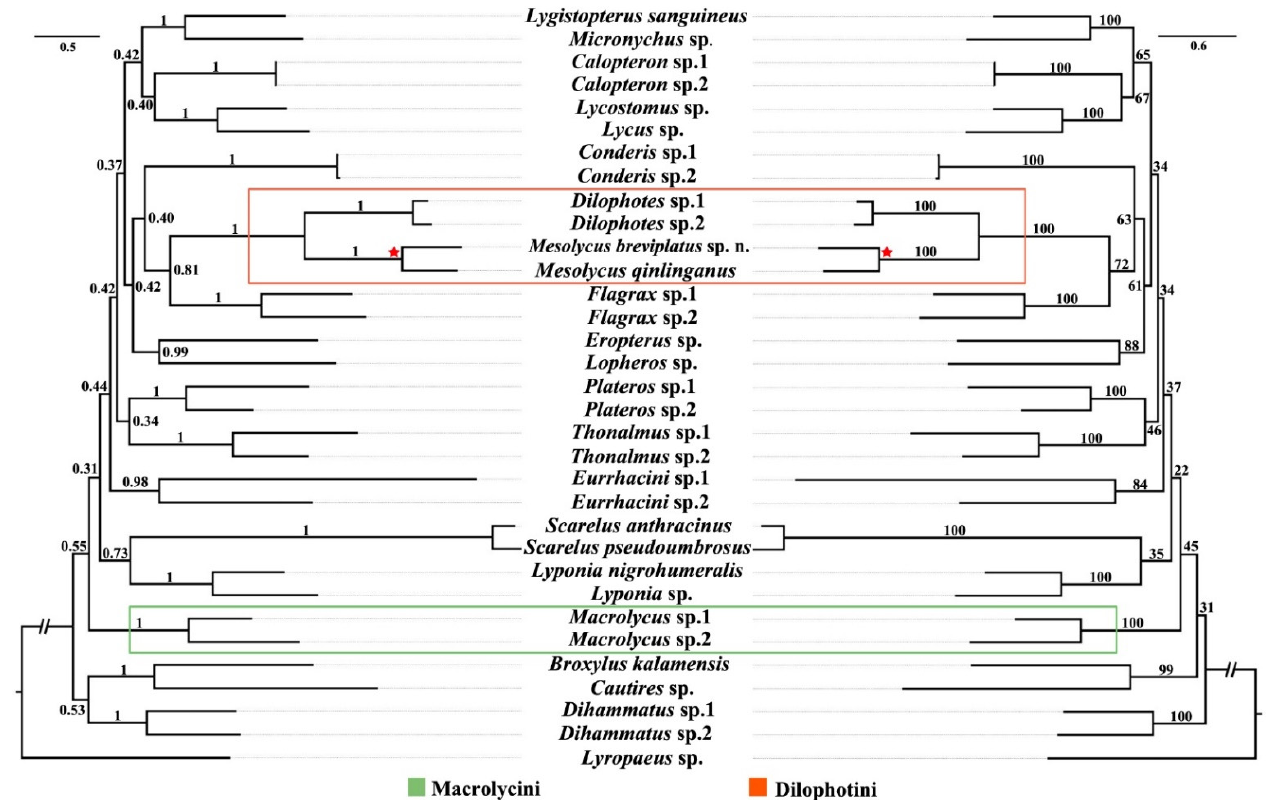
Figure 5. Phylogenetic tree of Lycinae produced from the ML ( right ) and BI ( left ) analyses based on the cox1 , nad5 , cox2 and Lrna genes. The numbers on the branches represent bootstrap (BS) ( right ) and posterior probability (PP) ( left ), respectively. Dilophotini is circled in orange and Macrolycini in green box. The pentagram represents Mesolycus species used in this study.